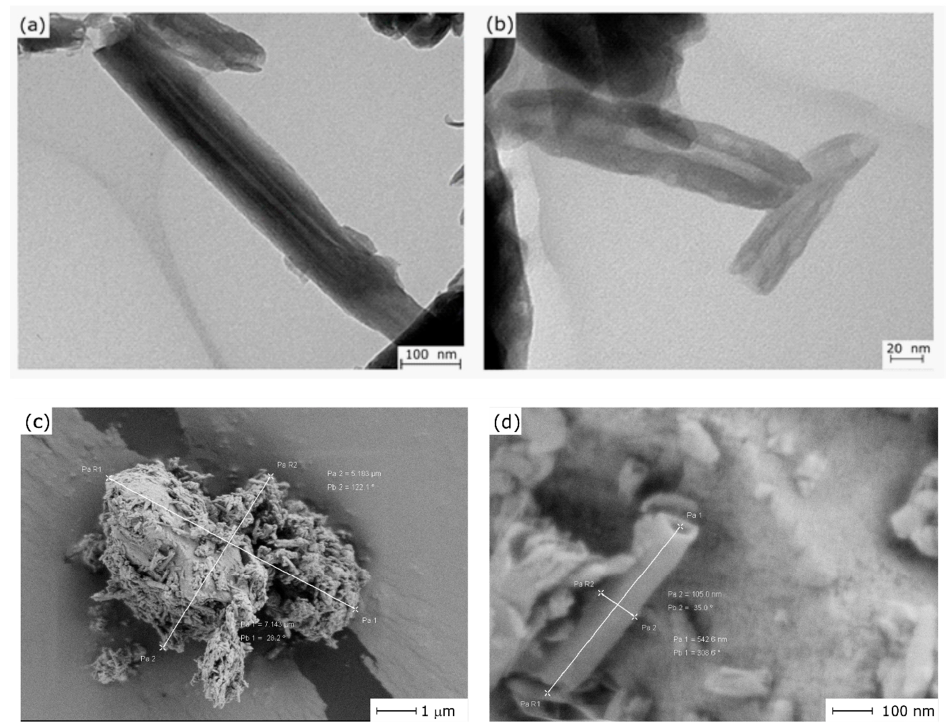
Figure 1. Different images showing the structure of halloysite nanotubes (HNTs). Transmission